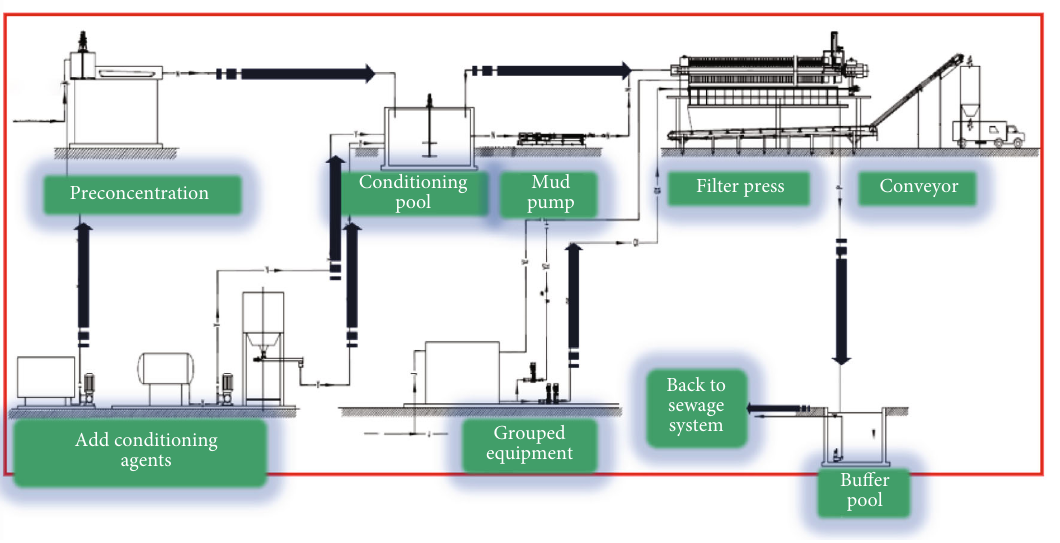
Figure 1: Sludge deep dewatering process fl ow chart.